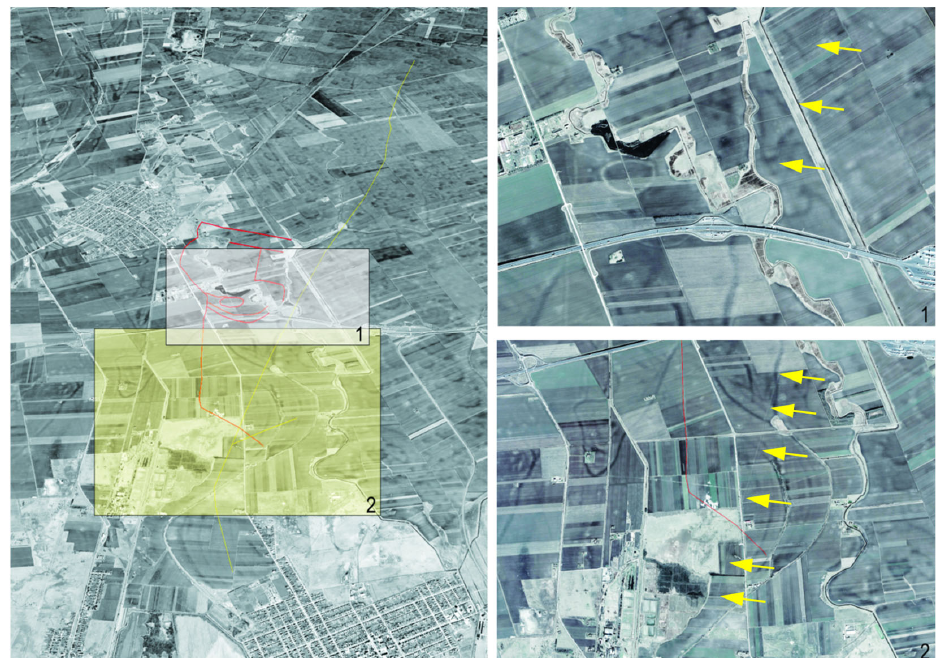
Figure 8. Edited March 2017 satellite image (available in Google Earth Pro). Left: the red lines denote easily traceable features; the yellow line denotes a linear feature identified in archaeological papers on the fortification’s south-eastern part. The yellow line runs approximately 13 km between N ă dlac and Mezhegyes. Right: Rectangles 1 and 2 show details of the regions highlighted on the left image—the yellow arrows indicate the linear feature.